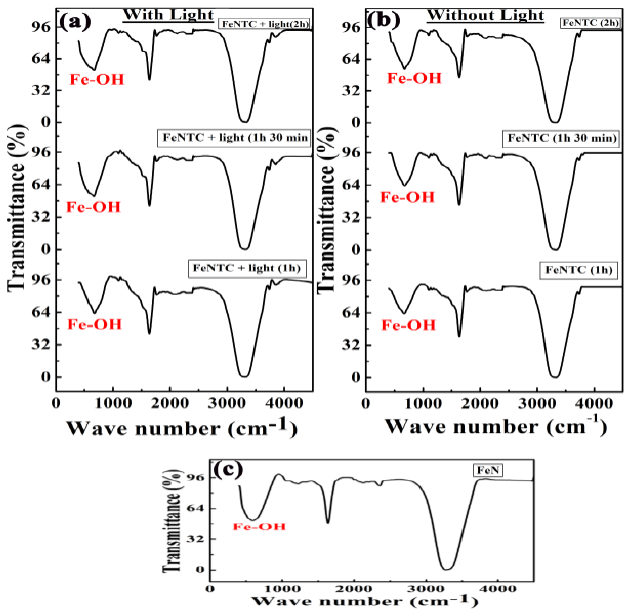
Fig. 3. FTIR spectra of ferric nitrate treated with TiO